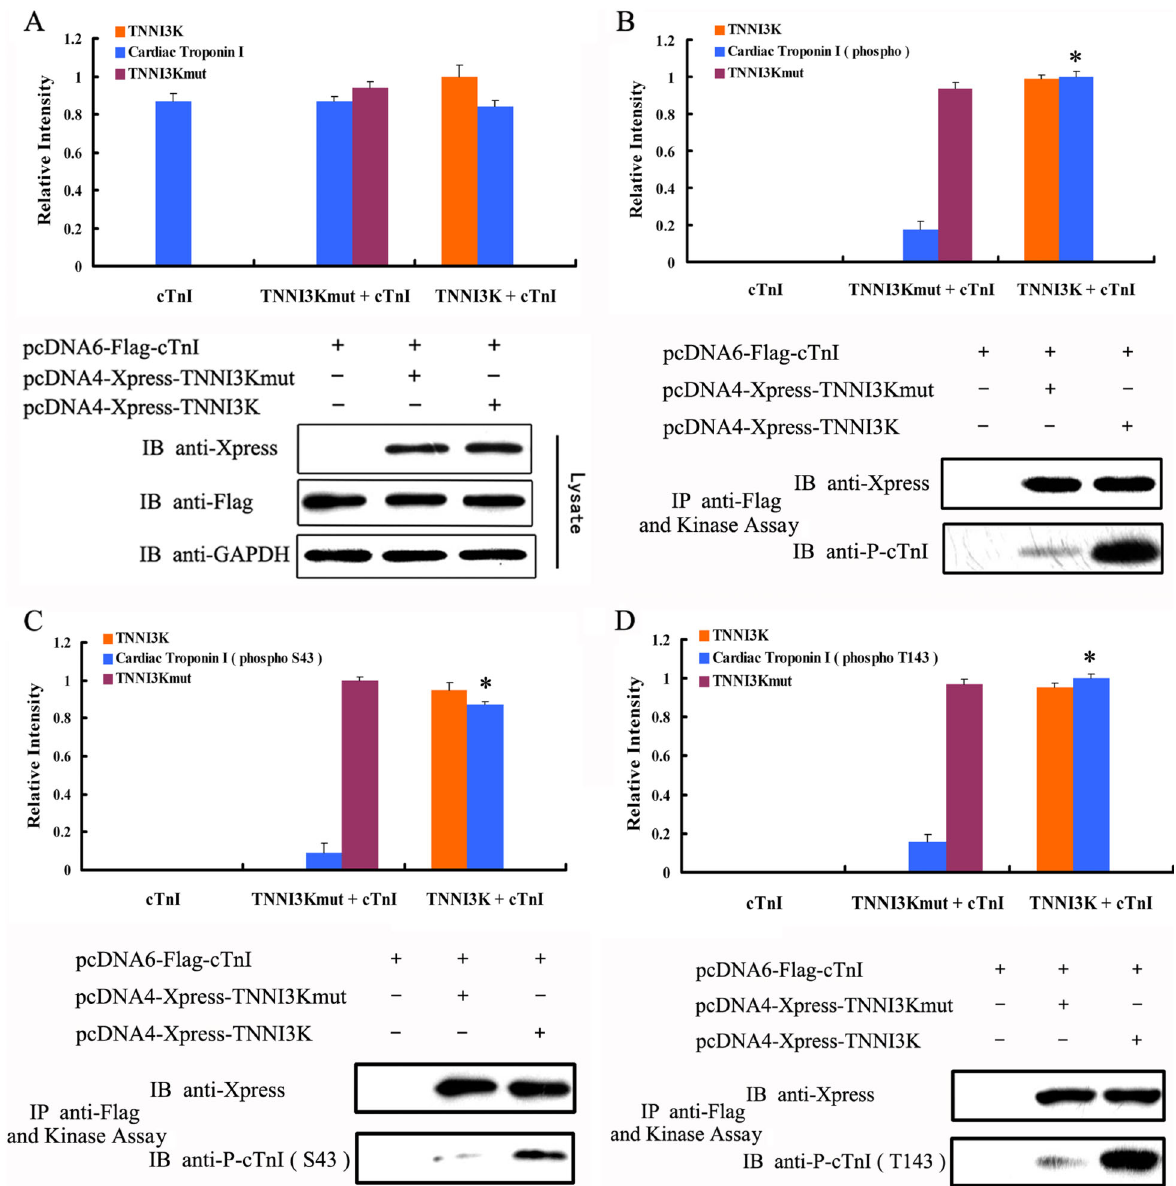
Figure 2. Human cardiac troponin I-interacting kinase (TNNI3K) phosphorylates cardiac troponin I (cTnI) at Ser43 (S43) and Thr143 (T143). HEK293T cells were transfected with Xpress-tagged TNNI3K, Xpress-tagged TNNI3Kmut, or Flag-tagged cTnI and incubated for 72 h. A , Western blot using anti-Flag and anti-Xpress antibodies (n = 5). B , Western blot using anti-Xpress and anti-p-cTnI antibodies (n = 5). C , Western blot using anti-P-cTnI (S43) and anti-Xpress antibodies (n = 5). D , Western blot using anti-P-cTnI (Thr143) and anti-Xpress antibodies (n = 5). IP = immunoprecipitated; IB = immunoblotted. Data are reported as means ± SE. *P , 0.01 vs TNNI3Kmut-mediated phosphorylation (one-way